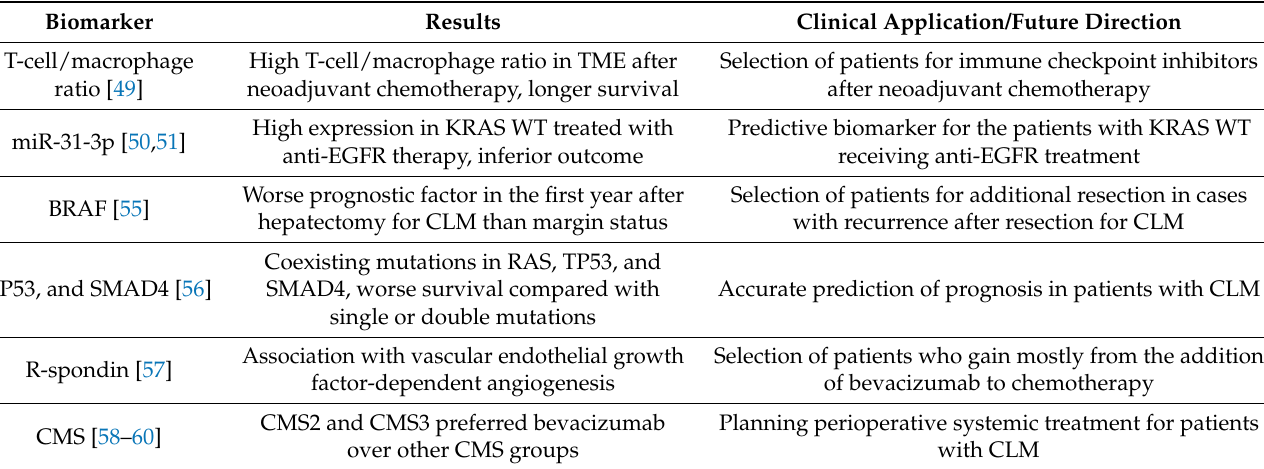
Table 3. Biomarkers in colorectal liver